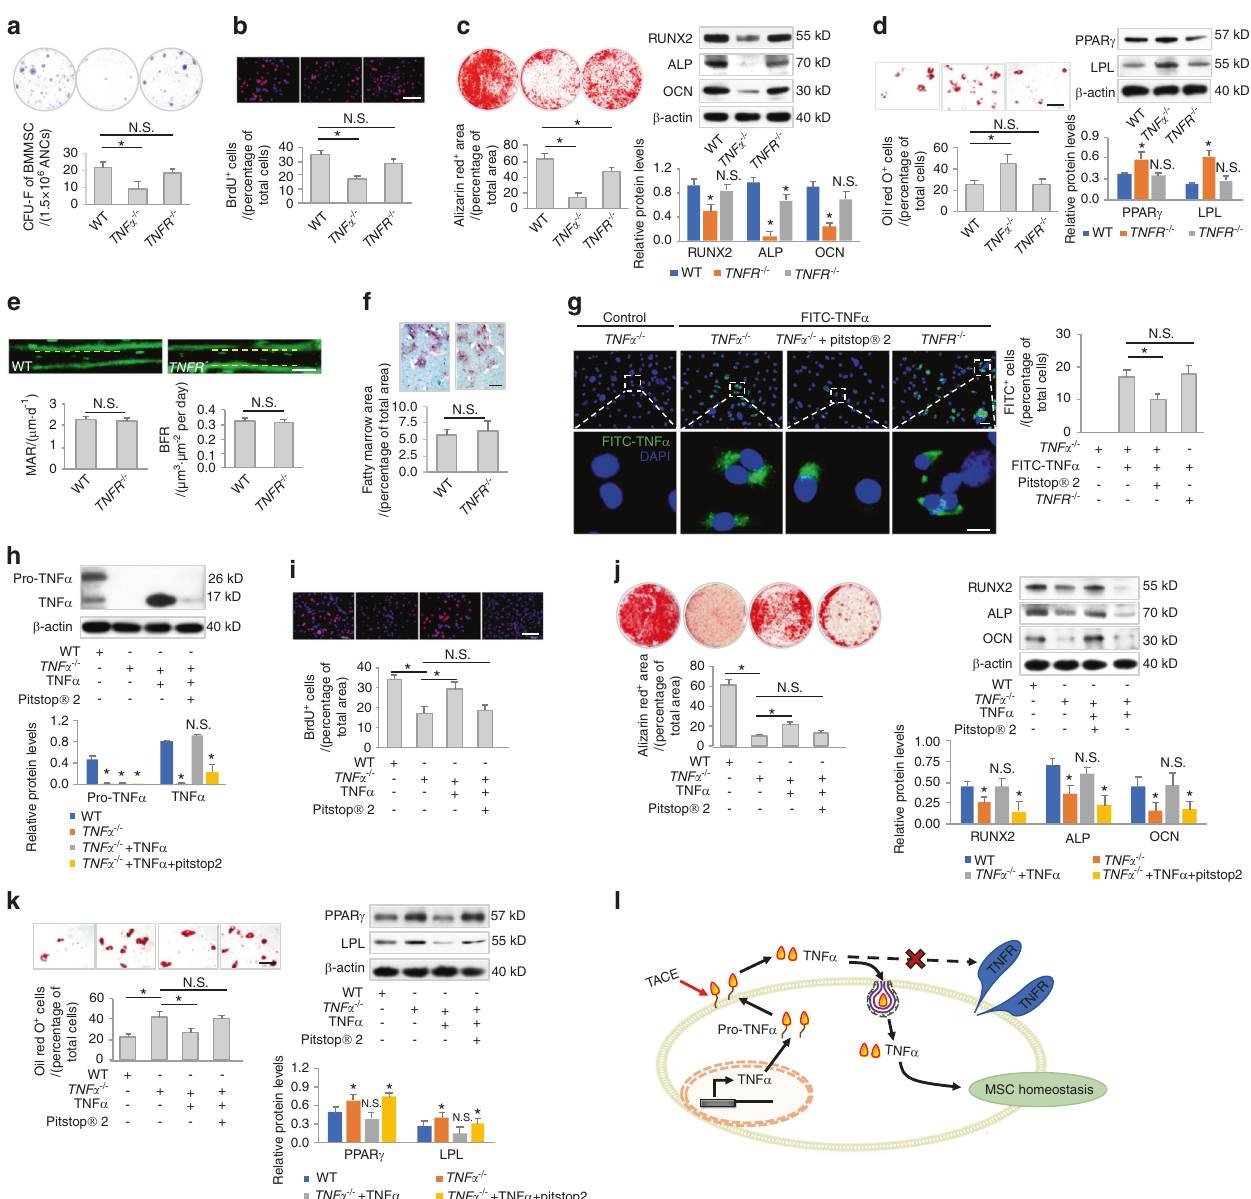
Fig. 2 TNF α safeguards MSC homeostasis in a receptor-independent manner through endocytosis. a – d Functional analyses of MSCs according to CFU, BrdU labeling, and osteogenic and adipogenic differentiation. MSCs were derived from WT, TNF α − / − or TNFR − / − mice ( N = 5). Scale bars = 100 μ m. e Calcein labeling for bone formation analysis in WT and TNFR − / − mice ( N = 5). Scale bar = 50 μ m. f Oli red O staining for bone marrow adiposity in WT and TNFR − / − mice ( N = 5). Scale bar = 150 μ m. g Endocytosis analysis of FITC-labeled TNF α uptake by MSCs for 24 h in vitro. Pitstop ® 2 was used to inhibit clathrin-mediated endocytosis at 12 μ mol·L − 1 . N = 3. Scale bars = 20 μ m (top) and 7 μ m (bottom). h Western blot analysis of protein expression levels ( N = 3). i – k Functional analyses of MSCs according to BrdU labeling and osteogenic and adipogenic differentiation. N = 3. Scale bars = 100 μ m. l Diagram showing that TNF α regulates MSC homeostasis in a receptor- independent manner through endocytosis. For quanti fi cation of Western blotting, a two-tailed Student ’ s t test was used for the comparison between the treatment and WT groups. * P < 0.05. N.S. not signi fi cant. Data represent the mean ±